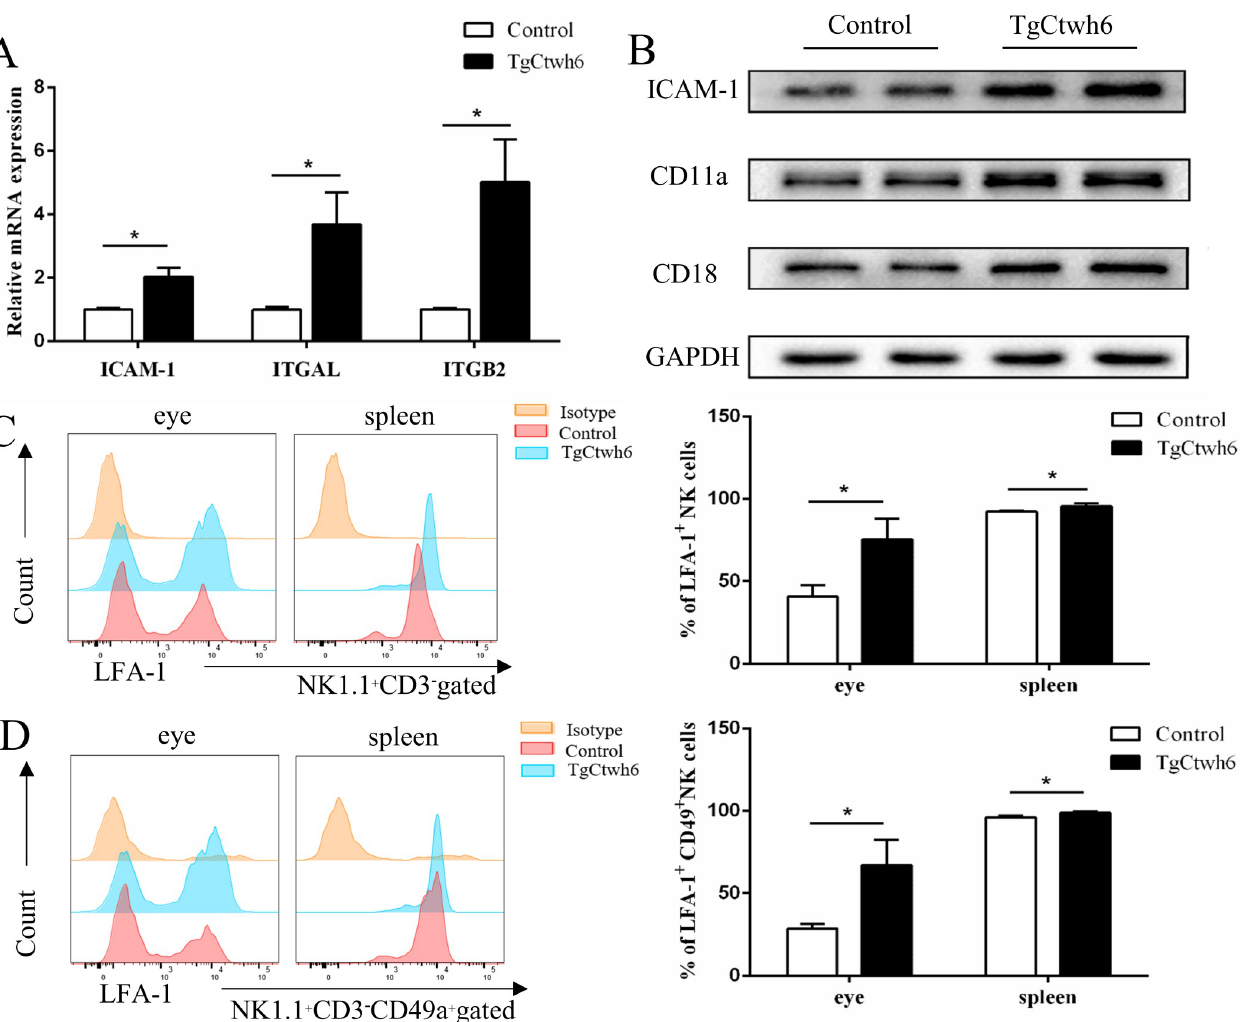
Fig 4. T . gondii infection upregulates the expression of ICAM-1 and LFA-1 by NK cells in murine ocular tissue. (A) The mRNA expressions of ICAM-1 and LFA-1 (ITGAL/ITGB2 gene) in ocular tissues of uninfected mice and TgCtwh6-infected mice were measured by using a Real-time quantitative PCR. GAPDH was used as an internal control. The results were representative of 3 independent experiments and the data were analyzed using Mann Whitney U test. mean ± SEM, � p < 0.05. (B) Western blot analysis showed that the protein expression of ICAM-1 and LFA-1 (CD11a/CD18) was upregulated in the eyes in comparison with the uninfected eye. GAPDH was used as an internal control. The results are from a pool of protein from two mice and are representative of results in three independent experiments. Expressions of LFA-1 on infiltrating CD3 − NK1.1 + cells (C) and CD49a + NK cells (D) in the eyes or spleen. Pools of 10 mice were used and experiments were replicated three times. The results were representative of 3 independent experiments and represented as mean ± SEM. The data were analyzed using Student’s t-test. mean ± SEM, � p < 0.05; �� p < 0.01.